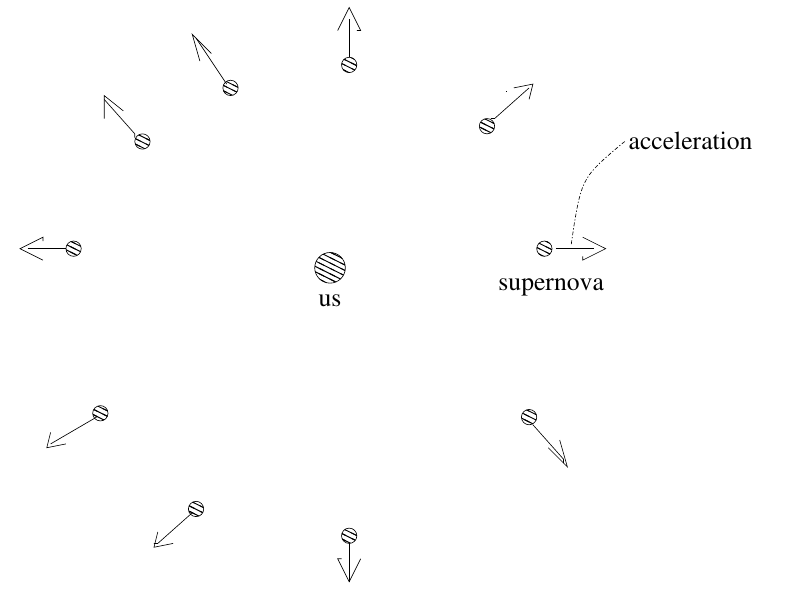
Figure 6. Supernovae acceleration via dark energy.